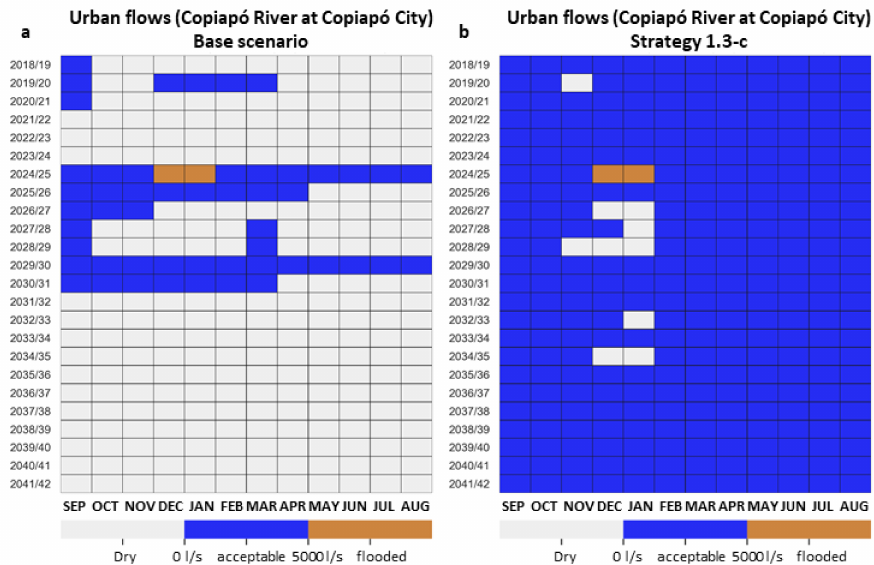
Figure 8. Monthly frequency of occurrence of urban flows at the Copiap ó City gauging station for ( a ) base scenario and ( b ) strategy 1.3-c, for dry, acceptable, and flooded thresholds. Blue cells record the occurrence of average monthly discharges greater than 0 L/s and less than 5000 L/s at Copiap ó